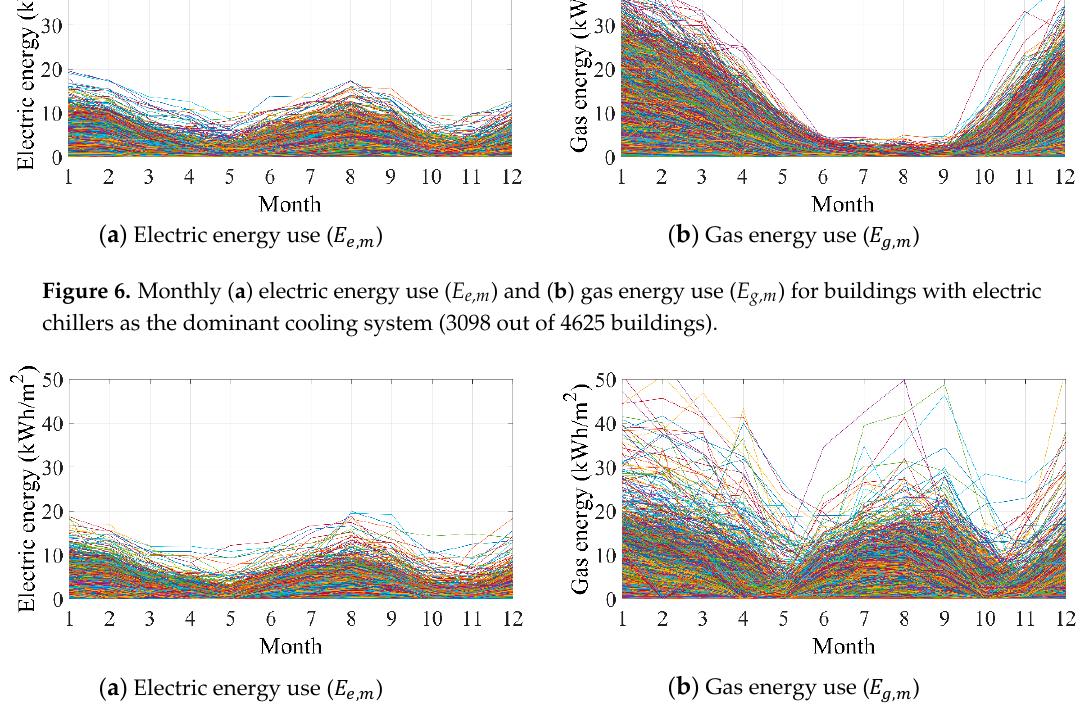
Figure 7. Monthly ( a ) electric energy use ( E e,m ) and ( b ) gas energy use ( E g,m ) for buildings with absorption chillers as the dominant cooling system (1527 out of 4625 buildings).